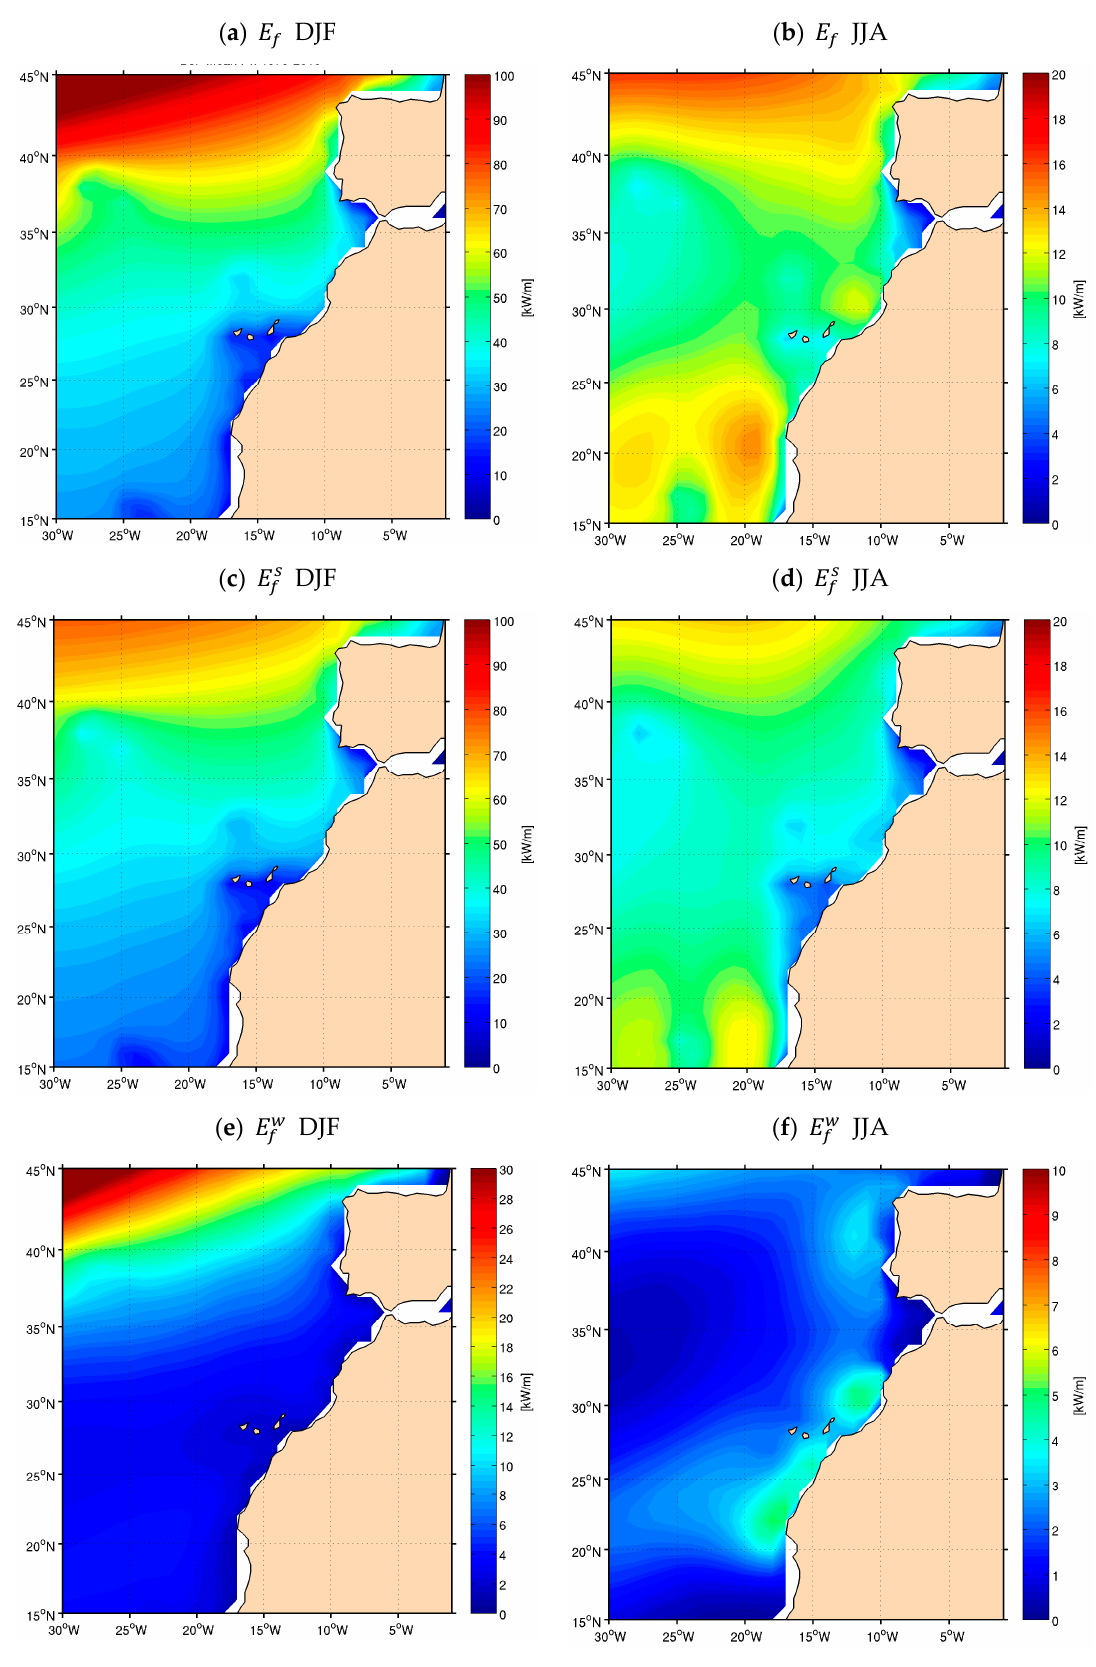
Figure 8. Climatological averages of the 99% percentiles of E f (W · m − 1 ) for ( a ) DJF and ( b ) JJA, of E s (W · m − 1 ) for ( c ) DJF and ( d ) JJA, and of E w (W · m − 1 ) for ( e ) DJF and ( f ) JJA. The color scales vary between seasons.